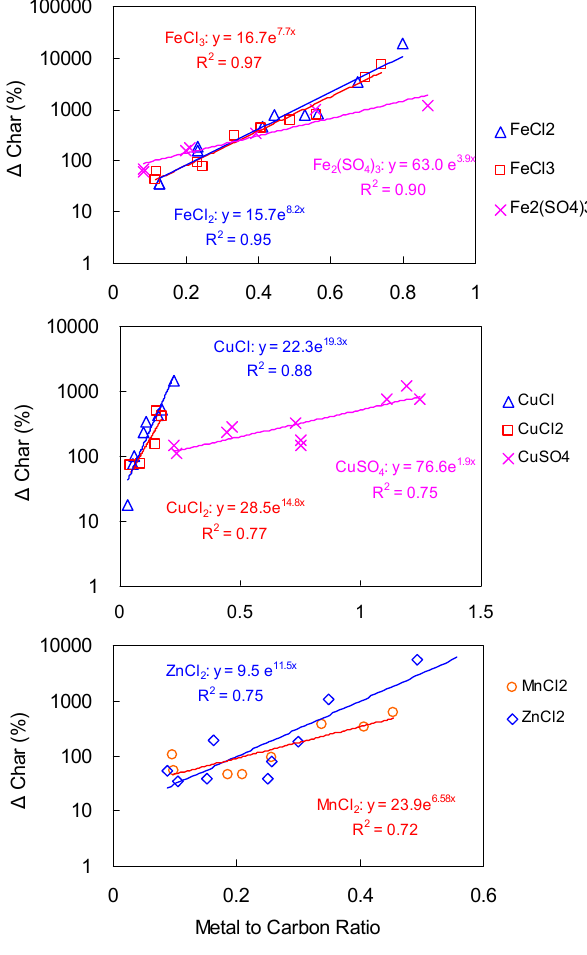
Fig. 3. The percent increase of char as a function of metal to car- bon ratio for transition metal-loaded diesel compared to diesel ref- erence samples. The values have been adjusted for the mass of TC (see text). The y-axis represents ([char] metal − loaded diesel sample - [char] diesel reference sample with matched TC loading )/ [char] diesel reference sample with matched TC loading × 100. Char: the percent reduction of laser transmittance through the filter during the inert heating phase of